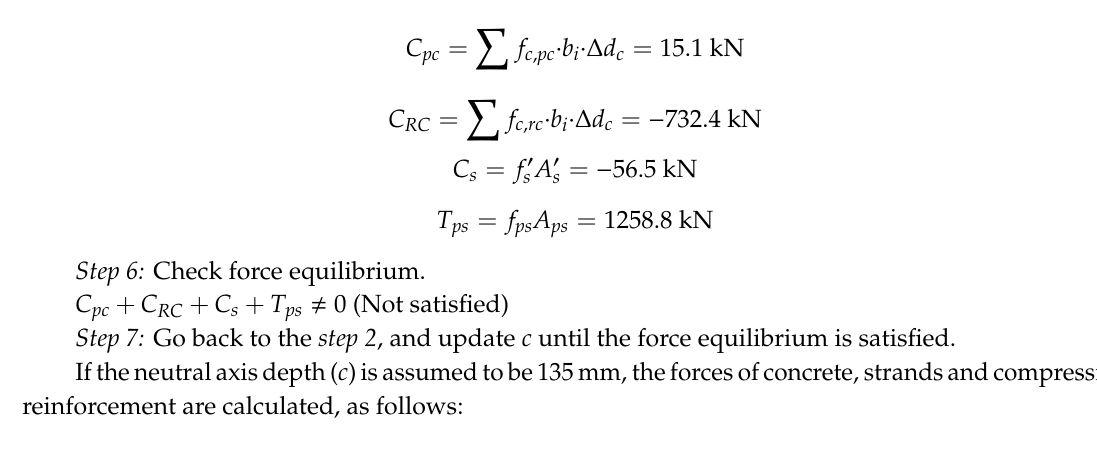
Figure A2. Strain distribution